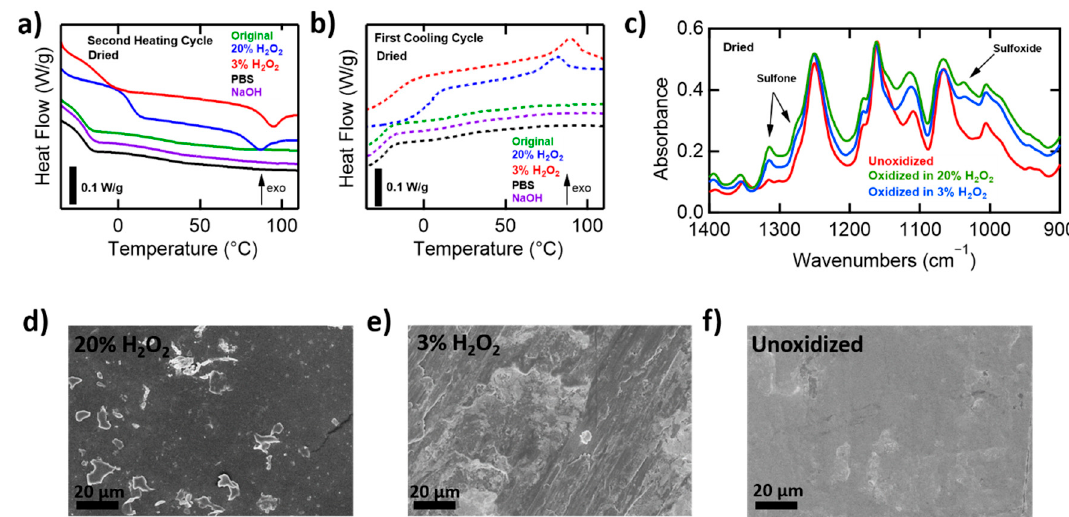
Figure 4. Material characterization of degraded LCE films after drying. ( a ) Differential scanning calorimetry (DSC) plot of second heating cycle. Heat flow as a function of temperature for 1 mm thick films after exposure to all media for 7 days and then dried compared to untreated LCEs. ( b ) DSC plot of first cooling cycle. ( c ) FTIR ATR results showing the effect of oxidation on 1 mm thick dried LCEs after exposure to oxidative media for 7 days. SEM images compare surface topographies of oxidized LCEs to unoxidized LCEs. ( d ) Effects of oxidation in 20% H 2 O 2 . ( e ) Effects of oxidation in 3% H 2 O 2 . ( f ) Unoxidized LCE.